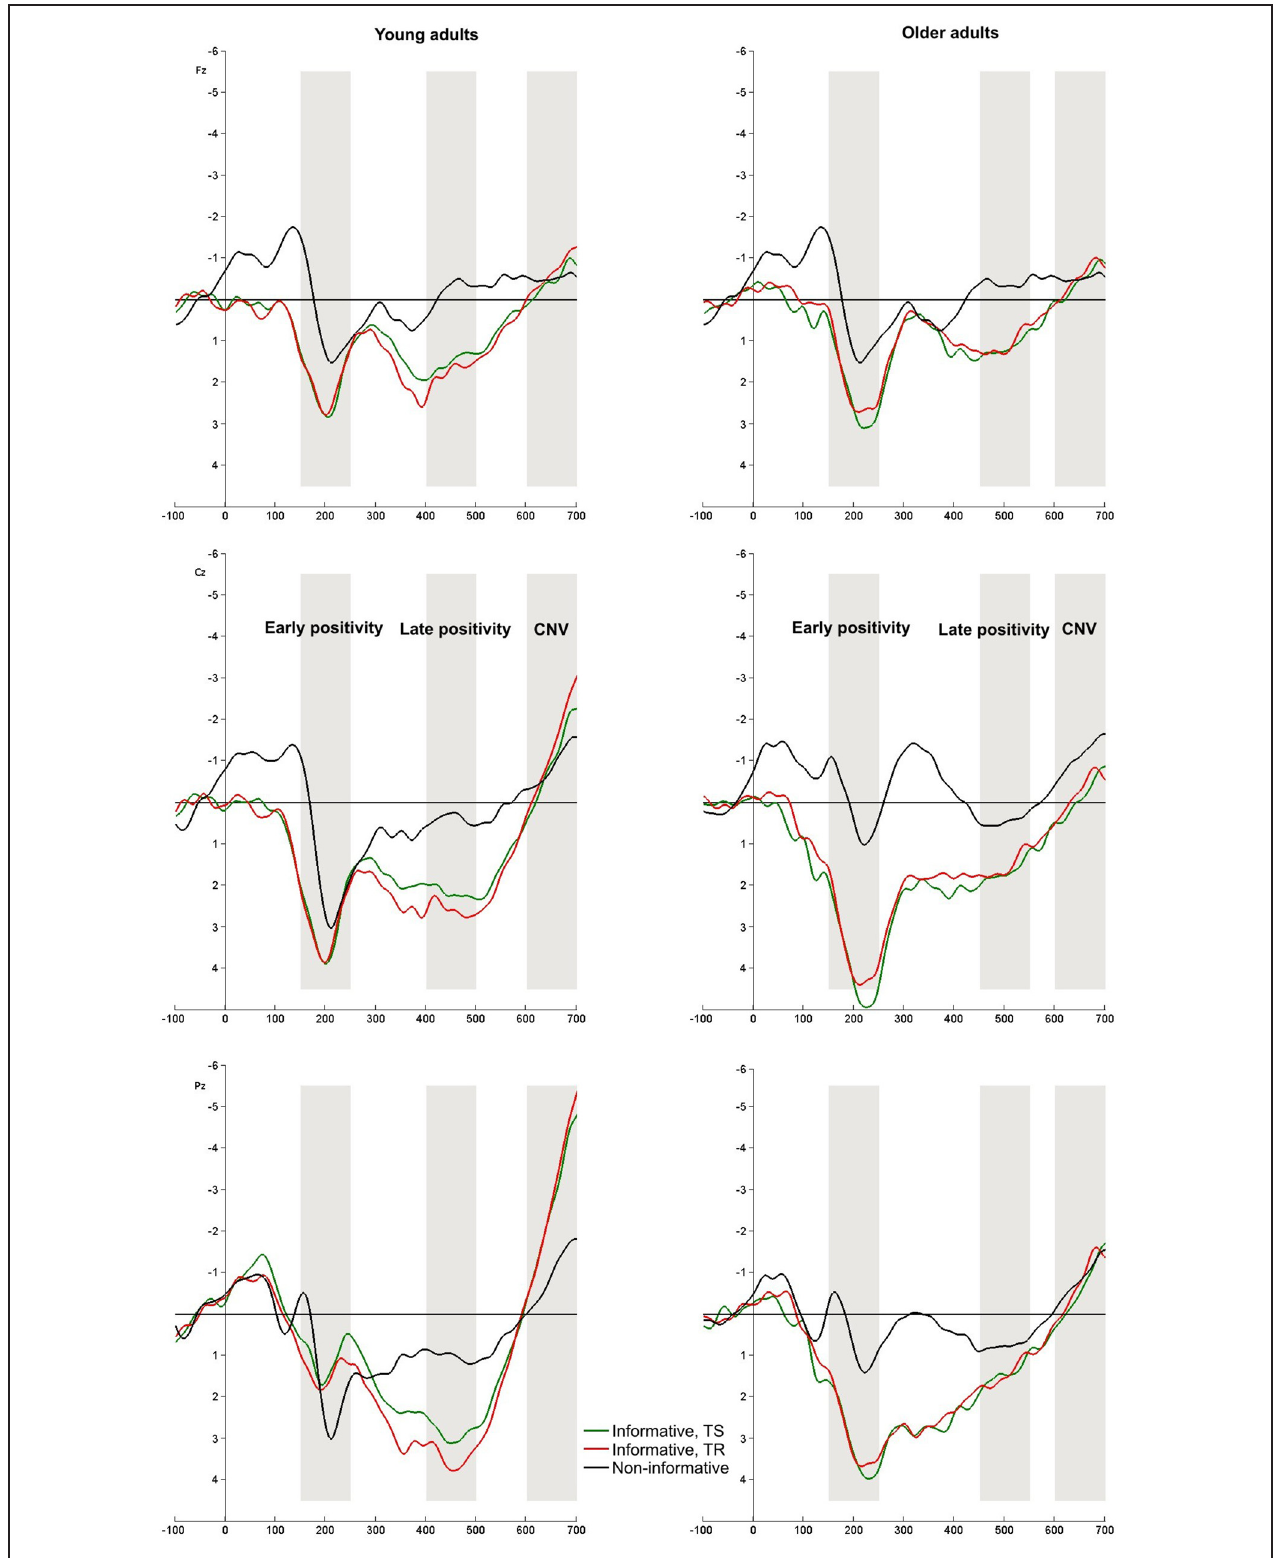
FIGURE 3 | Cue-locked ERPs at Fz, Cz, and Pz electrodes. Informatively cued (informative TS – green, TR – red) and non-informatively cued (black) conditions in young and older groups. Rectangles index the time windows of the analyzed ERPs: early positivity, late positivity, and early CNV.